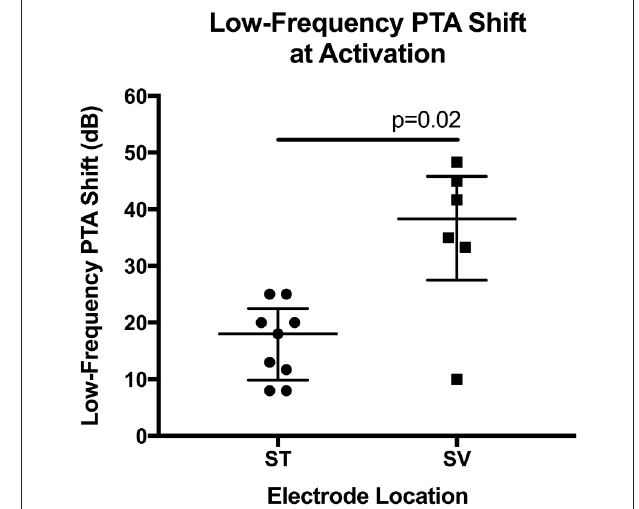
FIGURE 2 | Scatter plot of low-frequency pure-tone average (PTA) shift depicted according to scalar electrode location. Lower median shift (i.e., better hearing preservation) was noted when comparing electrodes inserted entirely into the scala tympani (ST) to electrodes that translocated into scala vestibuli (SV). Shown are the median and the range of the 25–75th